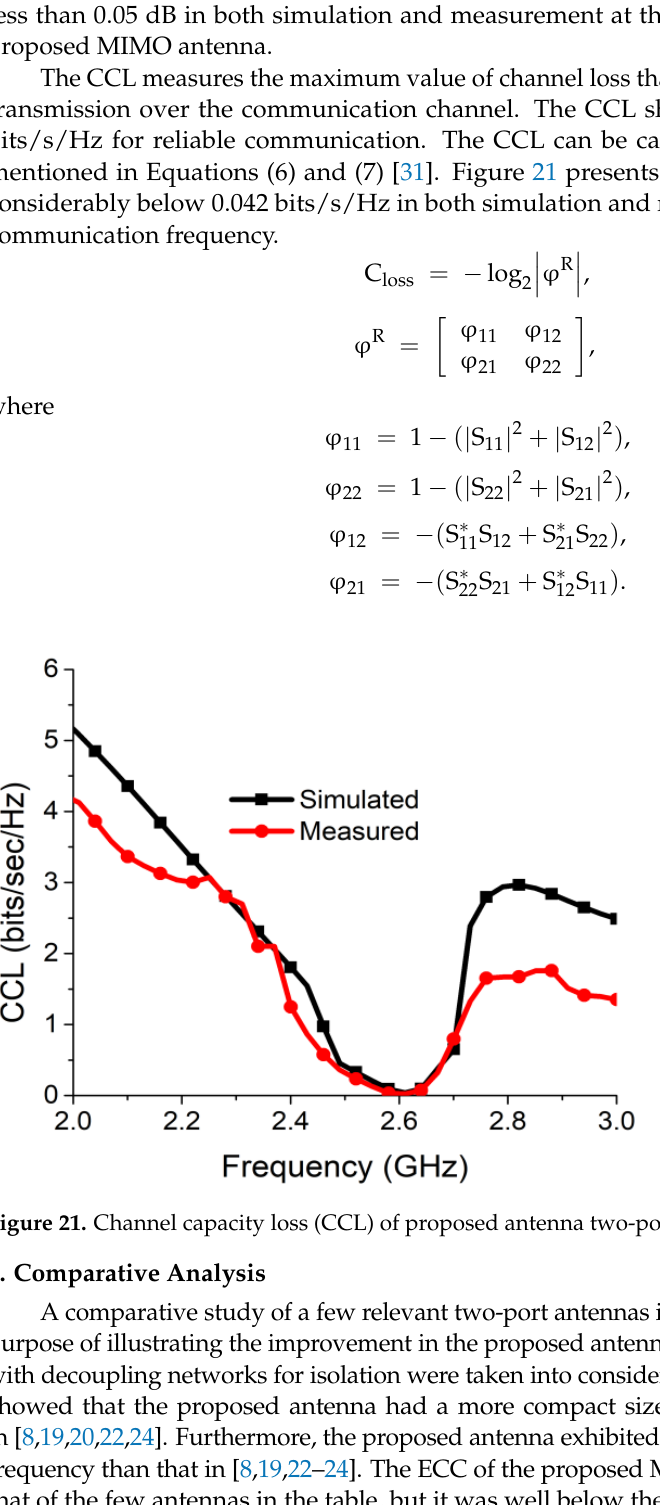
Table 1. Comparison with other decoupling network-based two-port MIMO antennas.